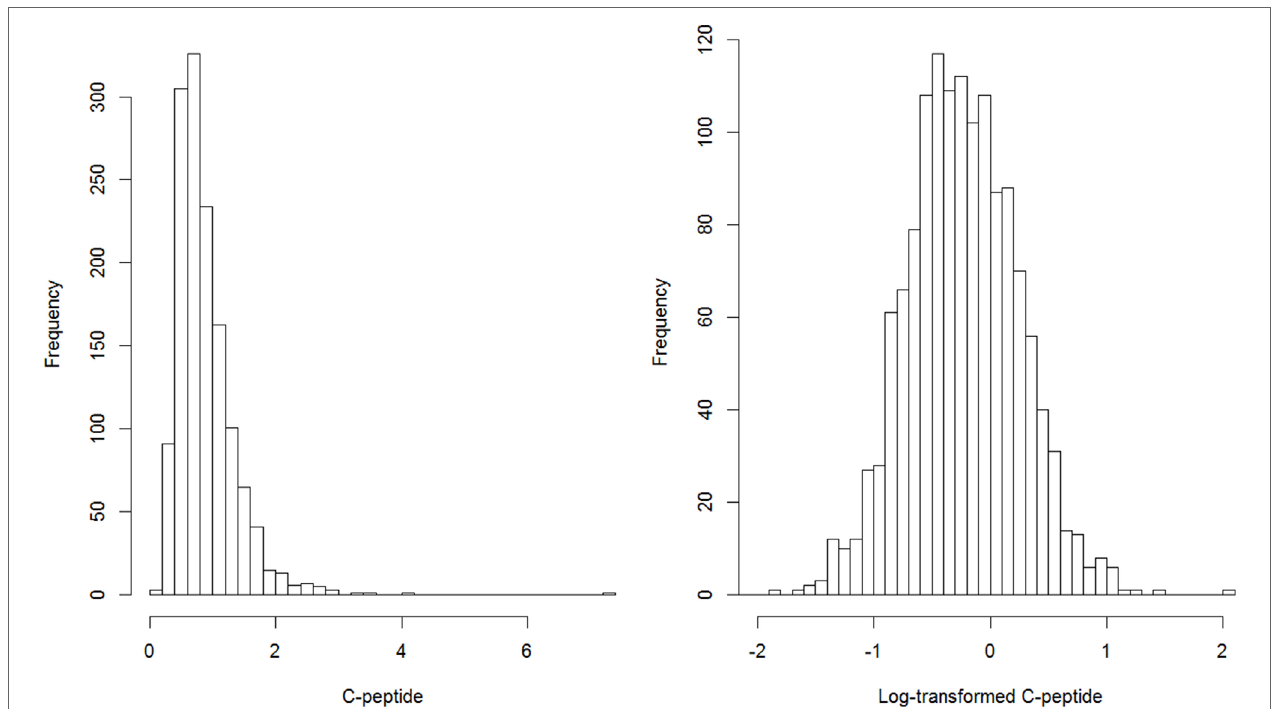
FigUre 1 | Distribution of C-peptide and Log-transformed C-peptide.